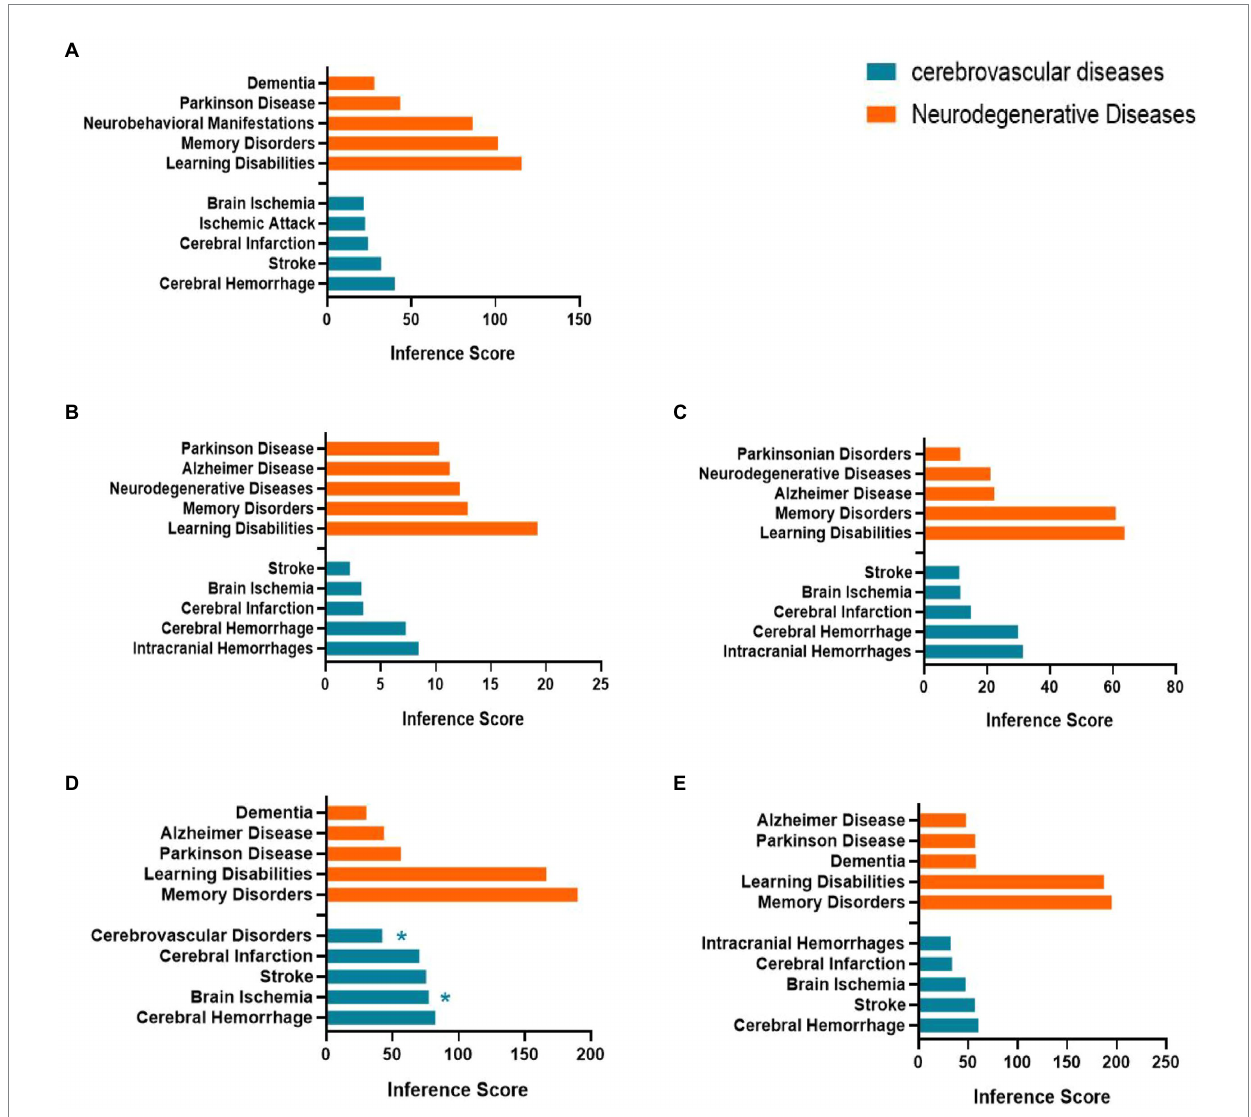
FIGURE 8 Relationship between Itgax (A) , Zfp51 (B) , Zfp62 (C) , Cxcl10 (D) , S100a8 (E) and aged related nervous system diseases. Data are from the Comparative Toxicogenomics Database. The top five of neurodegenerative diseases and age-related cerebrovascular diseases of each hub gene and S100a8 are listed in the bar charts based on the inference score. *, Direct evidence of marker or molecular change in this